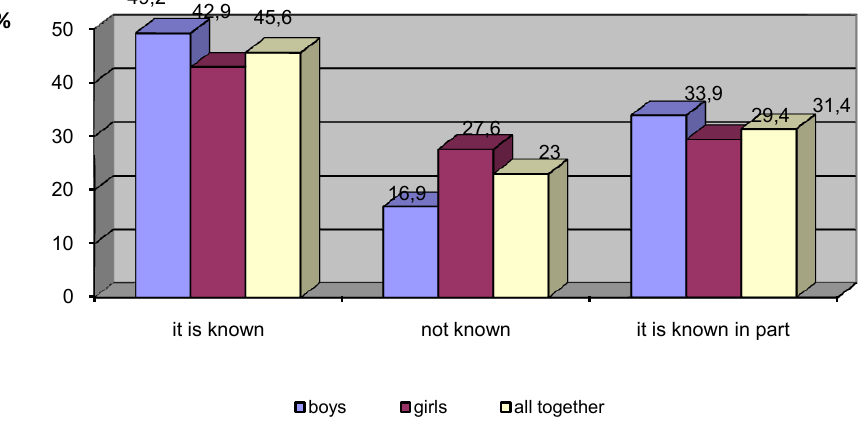
Fig. 2. Schoolchildren’s awareness of the subject of the Olympic Games